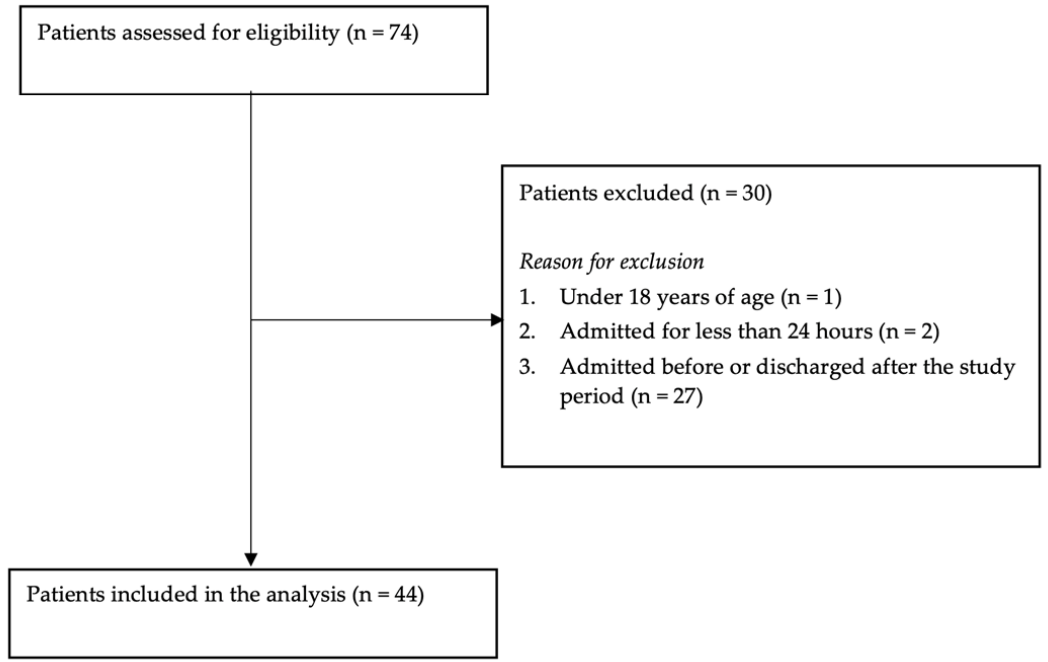
Figure 1. The flow of patients through the study.